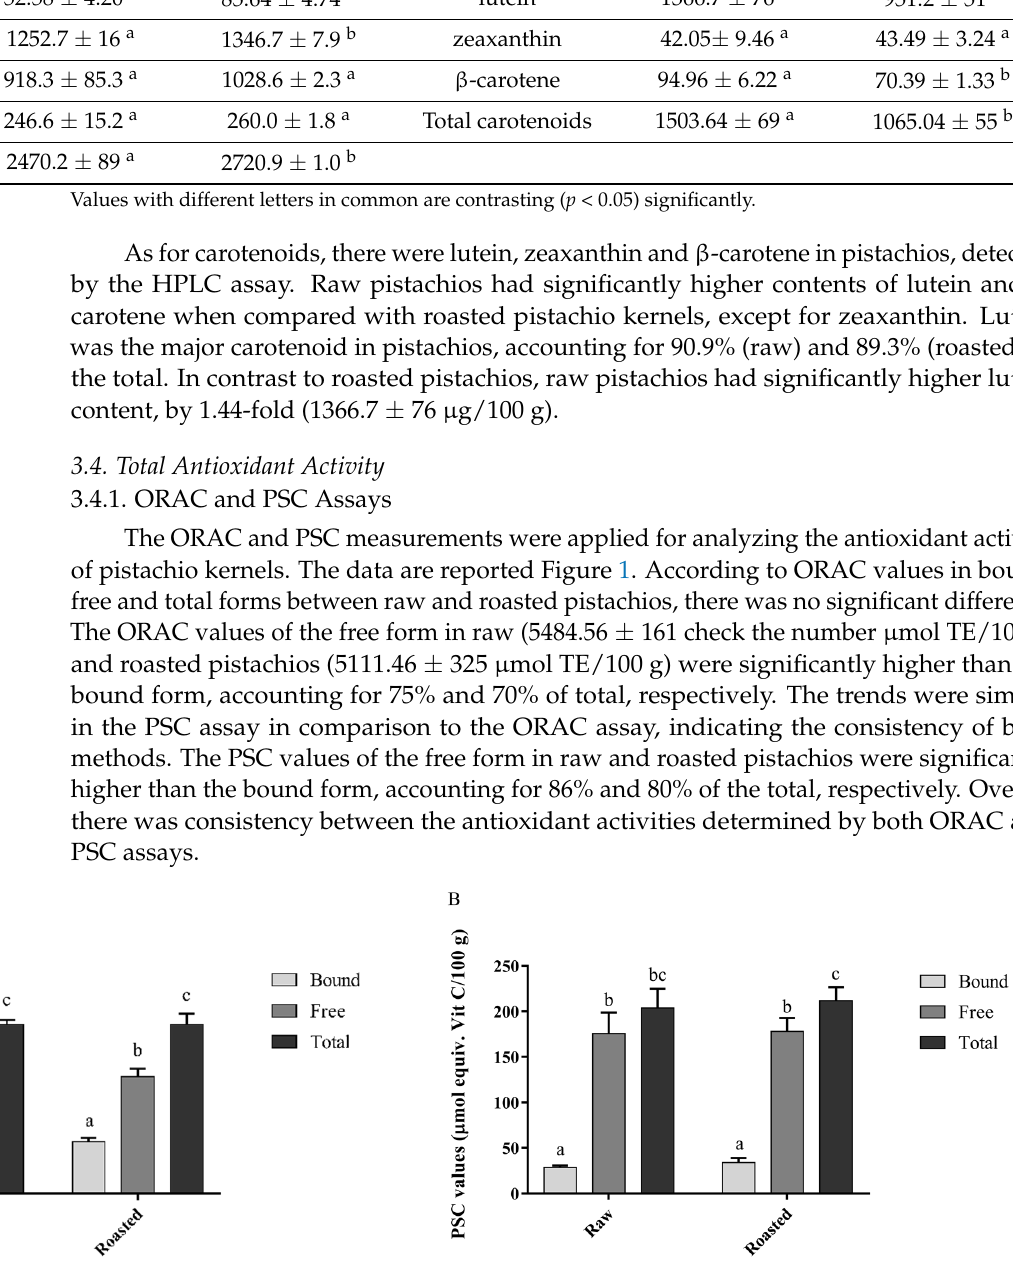
Figure 1. Total antioxidant activity of pistachios (raw and roasted) tested by ORAC ( A ) and PSC ( B ) assays. Values with different letters in each bar are contrasting ( p < 0.05)